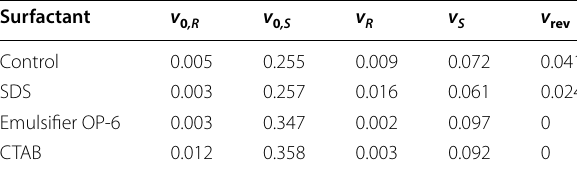
Table 1 Effect of surfactants on reaction